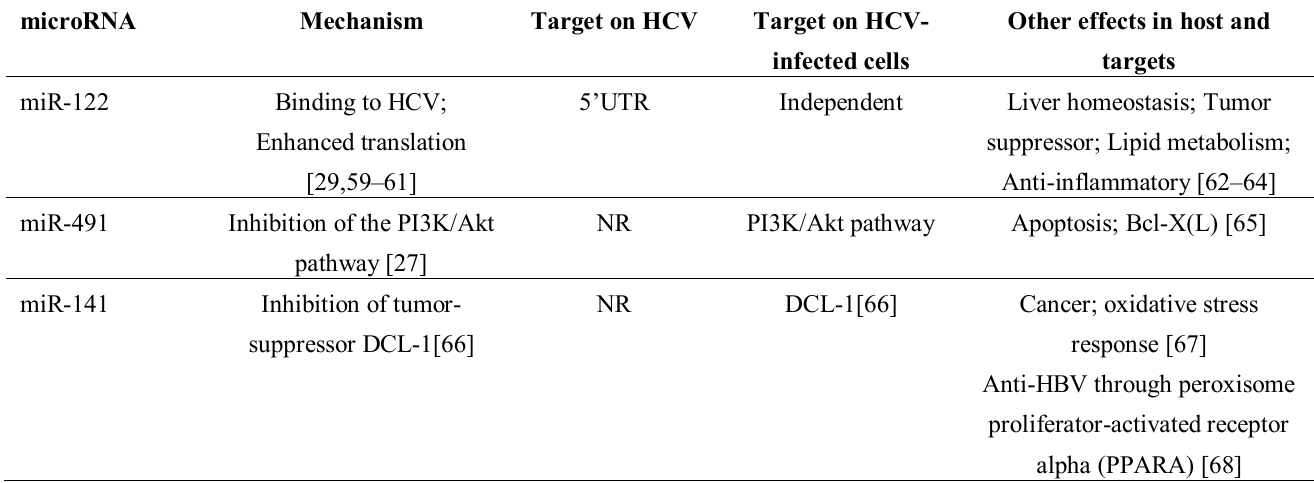
Table 1. MicroRNAs that enhance Hepatitis C virus (HCV)